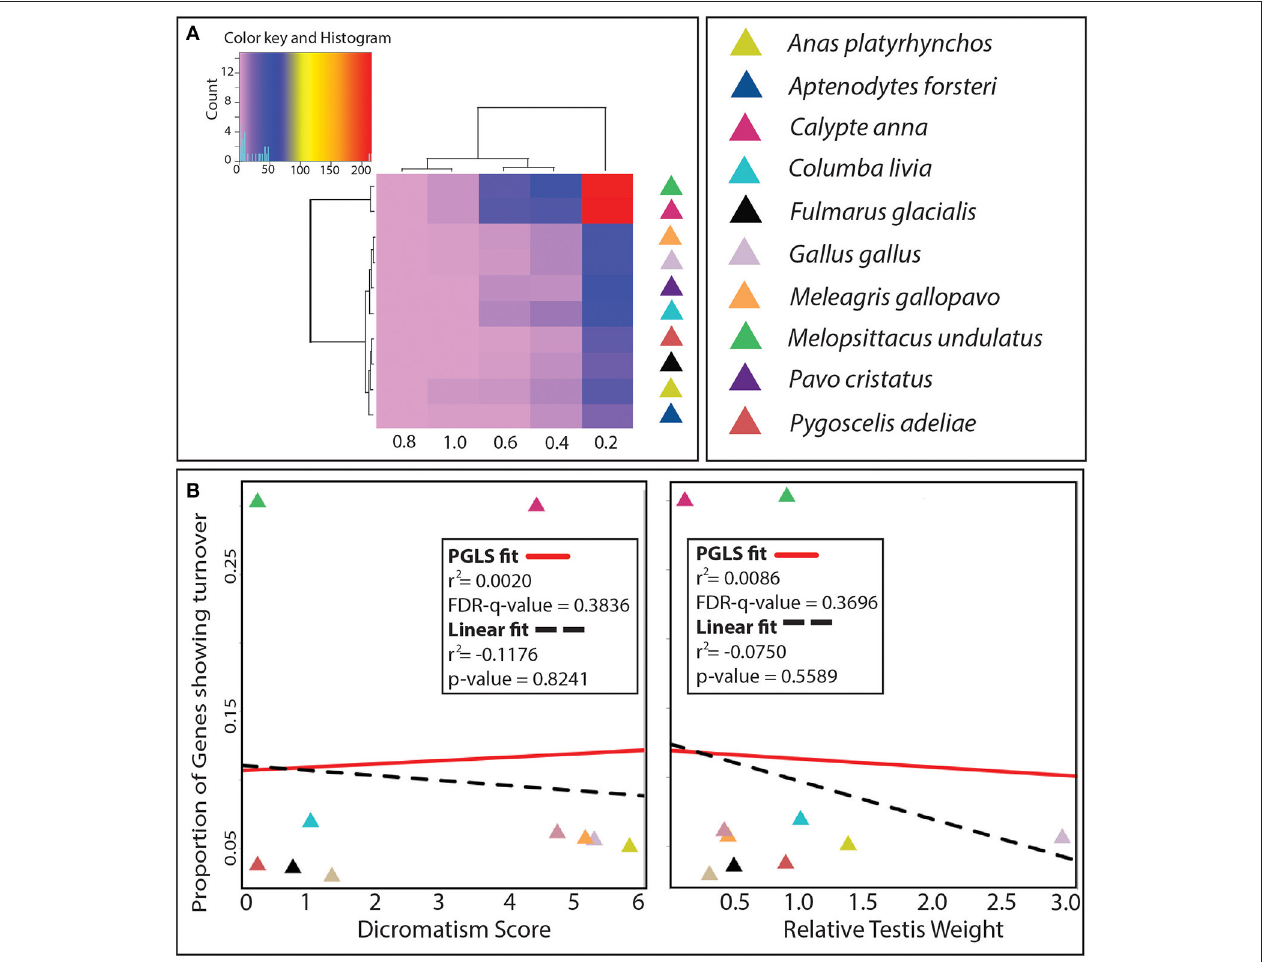
FIGURE 5 | Selection turnover across species. (A) Hierarchical clustering of 10 species based on the number of genes showing turnover for these species and r -squared values (from PGLS fit between ω and relative testis weight) divided into different intervals named after their upper bound (0.2 = 0–0.2, 0.4 = 0.2–0.4, 0.6 = 0.4–0.6, 0.8 = 0.6–0.8, 1.0 = 0.8–1.0). (B) The PGLS and linear model (LM) regression fits for the proportions of genes showing turnover against the pre-copulatory (Dichromatism score) and post-copulatory (Relative testis weight) measures of sexual